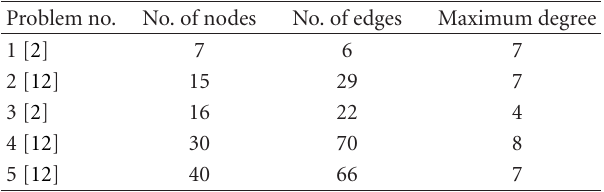
Table 5: Specifications of test cases.